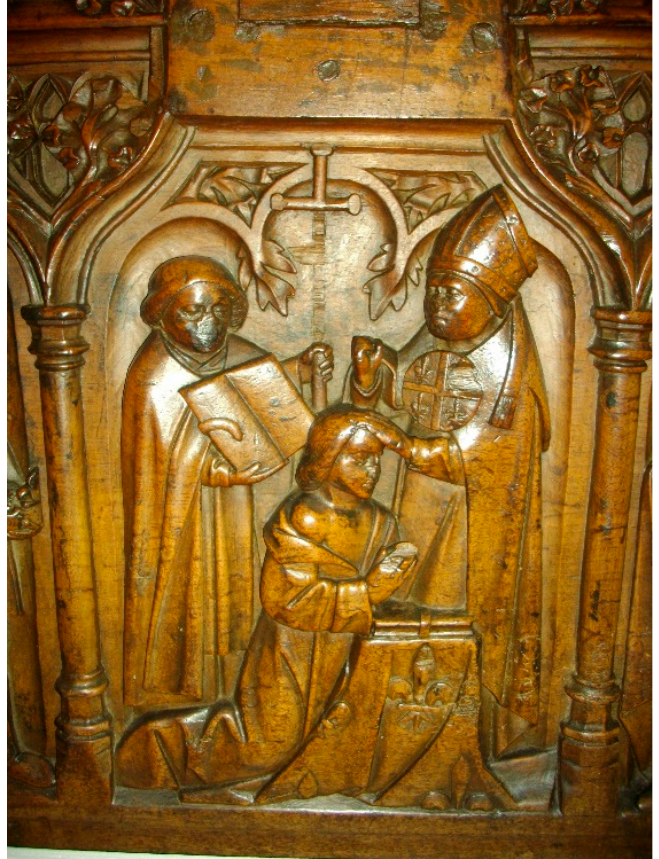
Figure 3. Coronation of Louis XI , carved oak panel on wooden chest, c. 1480, Orléans, Town Hall. Source: Wikimedia Commons, CC BY-SA 4.0 license.